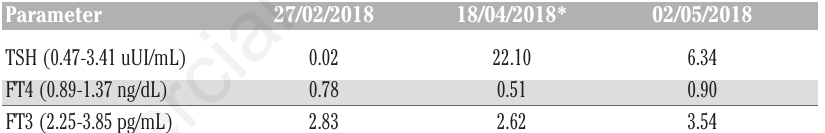
Table 1. Biochemical follow-up.